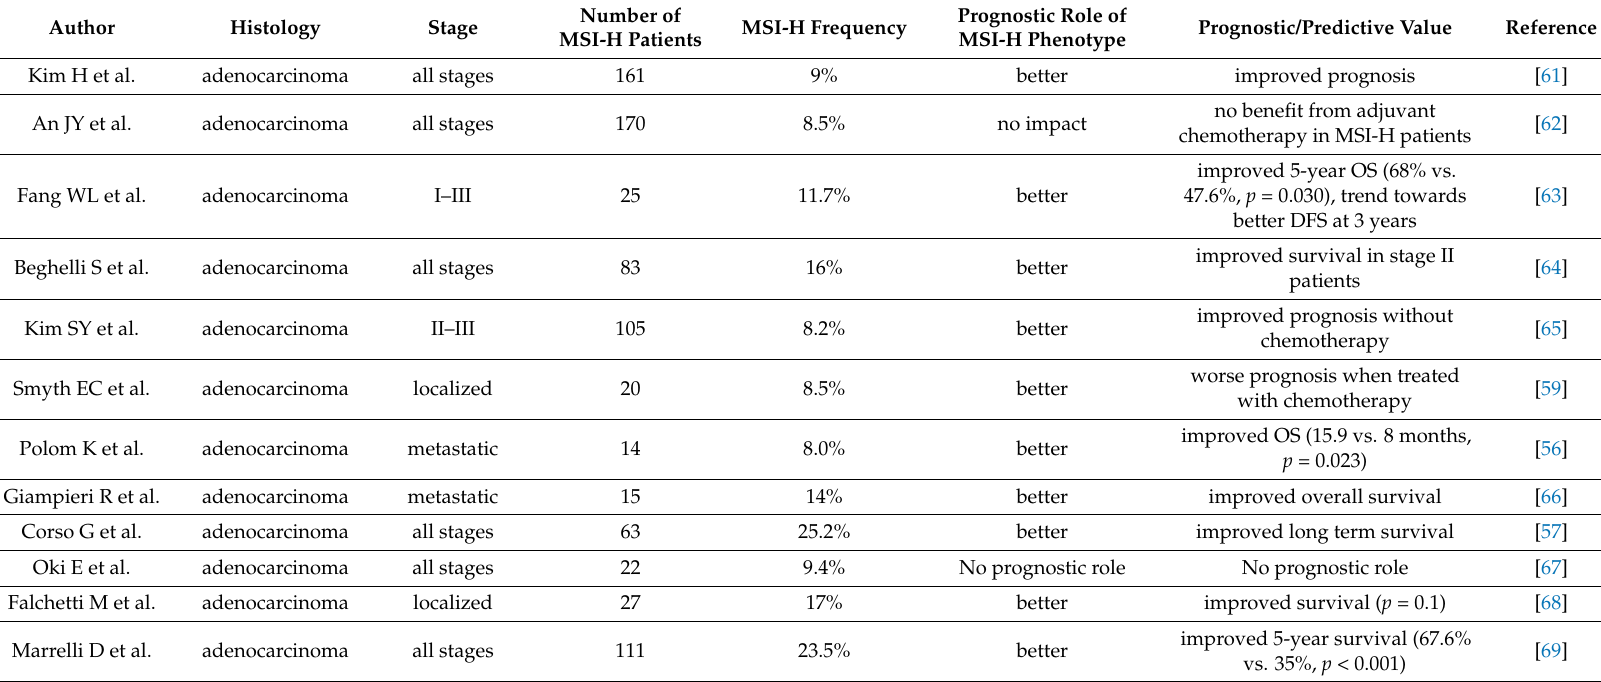
Table 3. Prognostic and predictive role of MSI-H phenotype in gastric